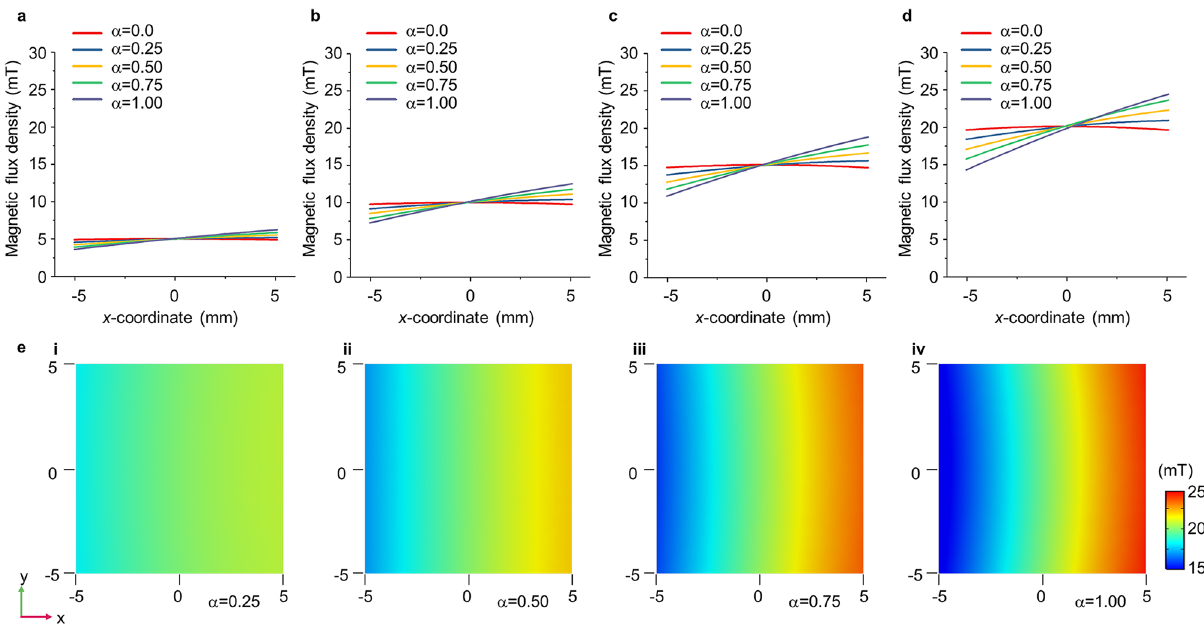
Figure 2. Controllable magnetic field in the channel. ( a )–( d ) The magnetic flux density profile in the channel along the x- axis with various values of α. The magnetic flux density at the center of the channel is set to ( a ) 5, ( b ) 10, ( c ) 15, and ( d ) 20 mT, respectively. ( e ) The magnetic field in the channel with a magnetic flux density of 20 mT for a parameter change from (i)–(iv) 0.25 to 1.00, respectively (COMSOL Multiphysics